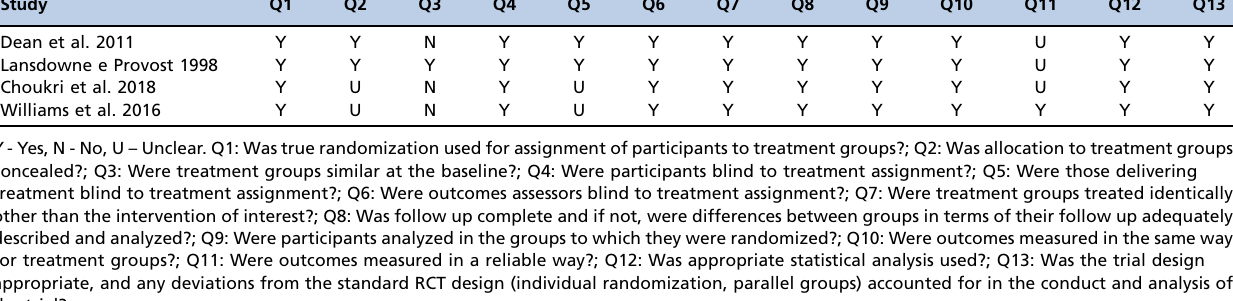
Table 2 - Critical appraisal results for included studies using the Joanna Briggs Institute for verification of randomized clinical trials. Study